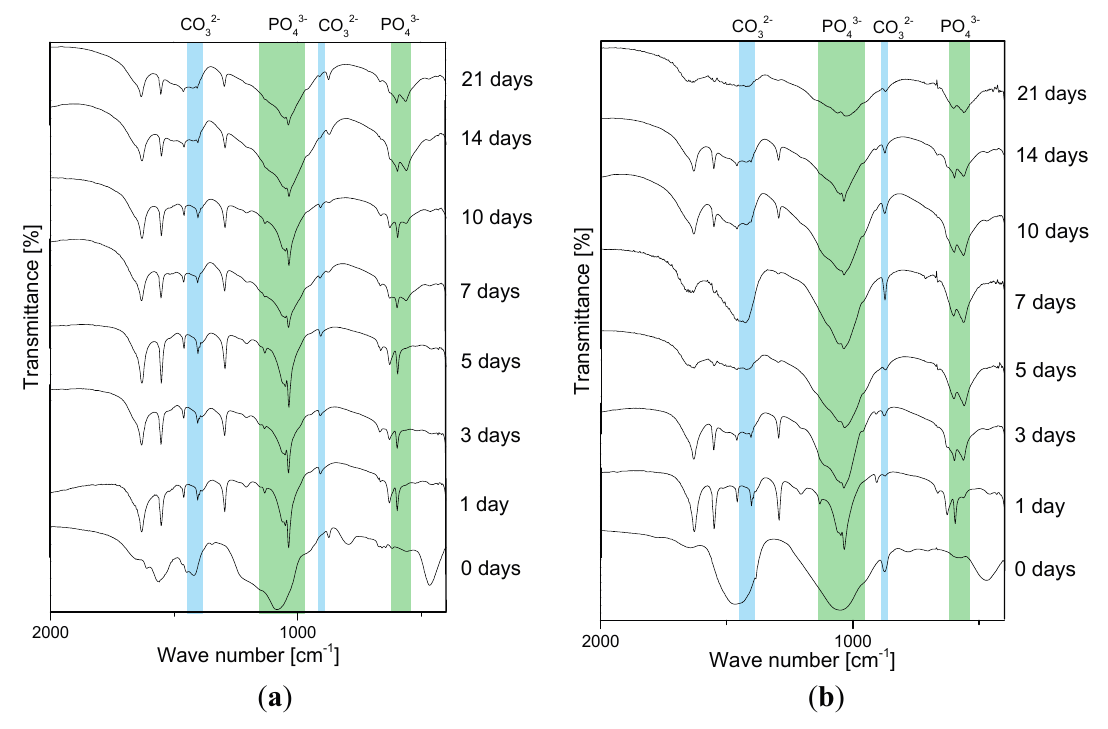
Figure 4. Fourier transform infrared (FTIR) spectra of chitosan/BG composites